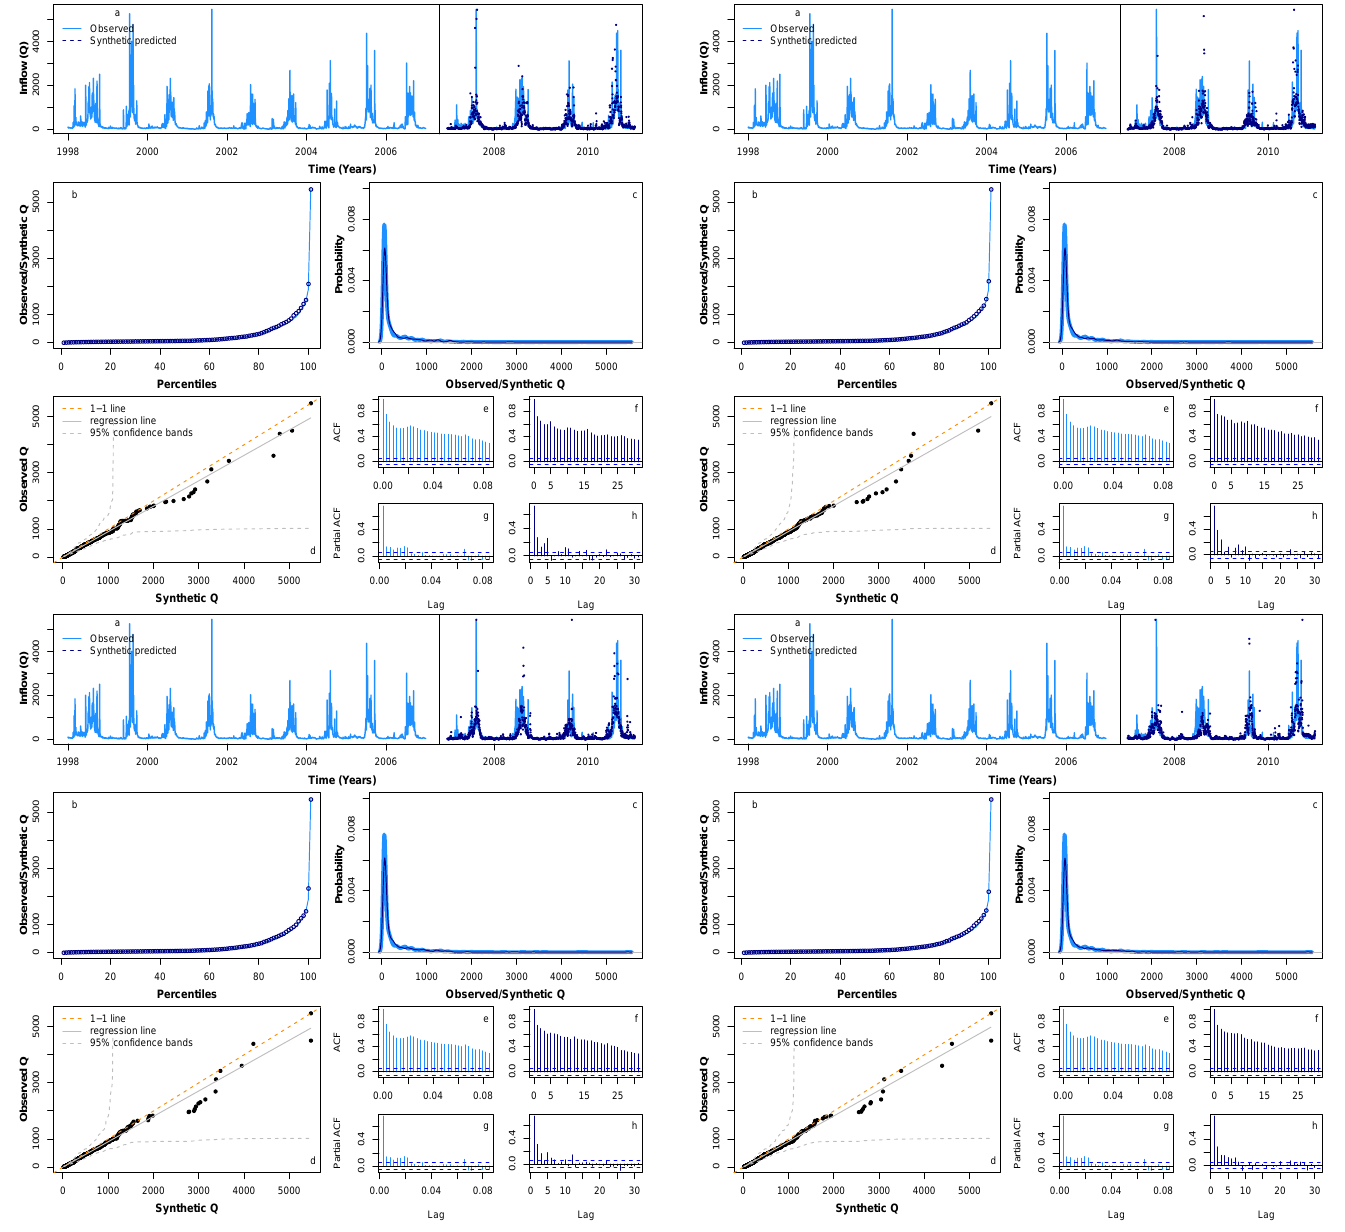
Figure 11. Comparison of four sample predicted inflow time series during the period 2007–2010. This figure is aimed to illustrate the performance of model for additional four samples and is a cluster of four subfigures that contains 8 subsubfigure each (listed as a – h ) for consistency. See Figure 10 for individual subsubfigure details.